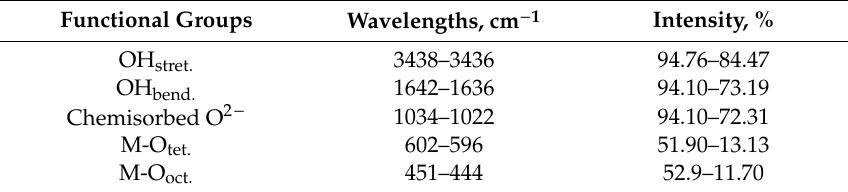
Figure 3. FTIR patterns of S1, S2, S3 and S4 samples. Table 2. Characteristic infrared frequencies of the as prepared materials.